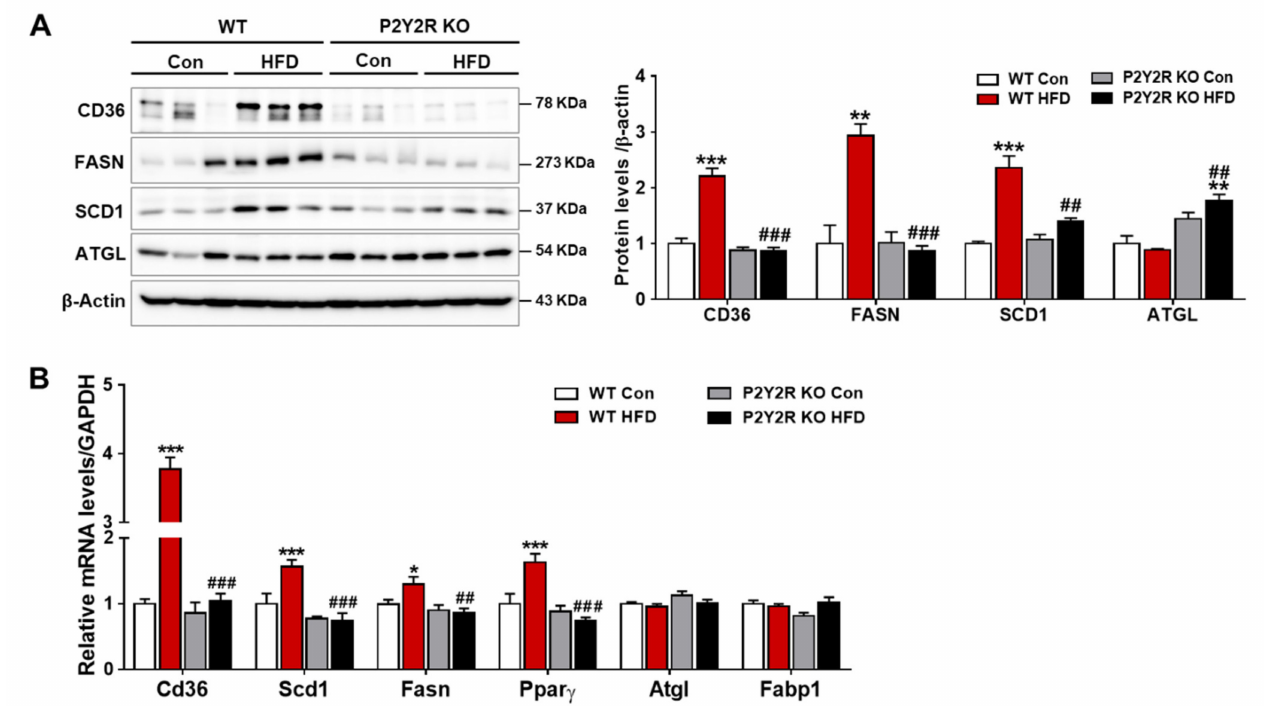
Figure 3. P2Y2R deficiency decreases de novo lipogenesis in HFD-fed mice. ( A ) Liver tissues were lysed to perform western blot analysis and the levels of proteins regulating lipid metabolism (CD36, FAS, SCD1 and ATGL) and β -actin (a loading control), were examined. Quantitative analysis of each protein was shown ( n = 5). ( B ) The expression of genes involved in lipogenesis and lipolysis was determined by real-time PCR analysis. Relative mRNA levels were normalized to those of GAPDH ( n = 3–5). Data are presented as the mean ± SEM. One-way ANOVA was used for statistical analysis followed by Bonferroni’s multiple comparison test. * p < 0.05, ** p < 0.01, *** p < 0.001 vs. WT control mice; and ## p < 0.01, ### p < 0.001 vs. WT HFD